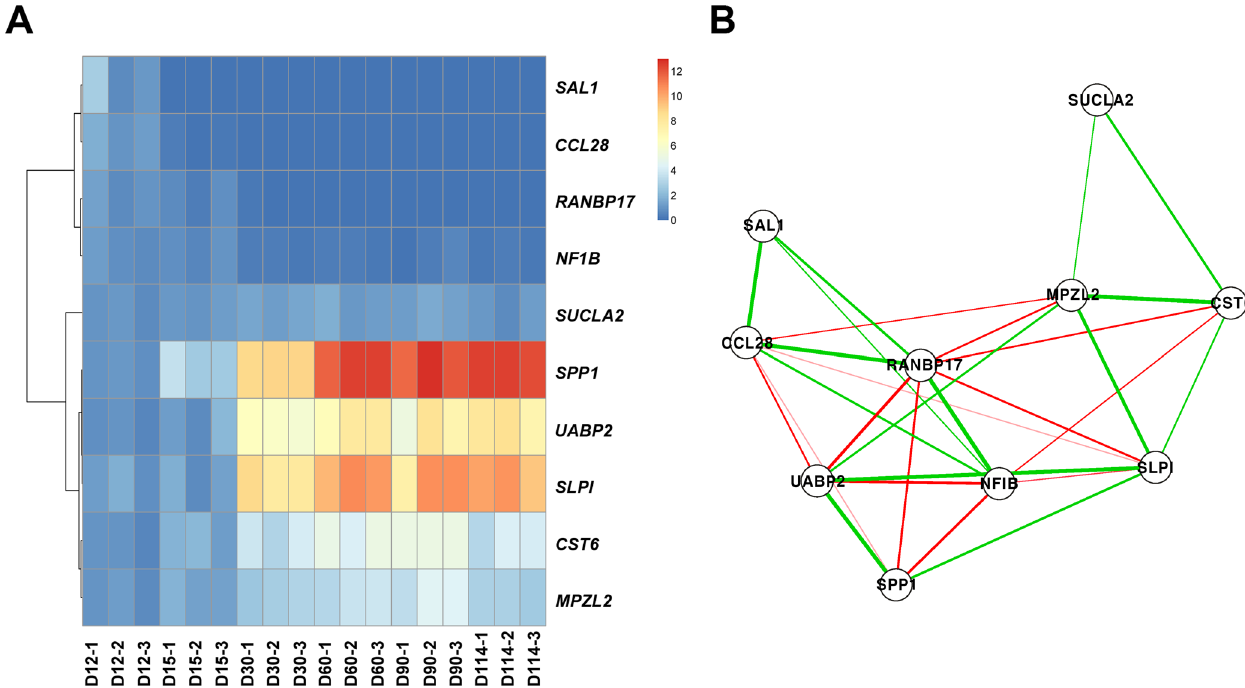
Fig 4. Real-time RT-PCR analysis to technically validate hub genes and correlated genes. (A) Heatmap with hierarchical clustering using 2 - ΔΔ CT values of 10 genes in real-time RT-PCR. (B) Correlation-based network plot. The edges represent significant correlation (FDR adjusted P-values < 0.05 in Pearson correlation test), and green and red colors represent positive and negative correlation,